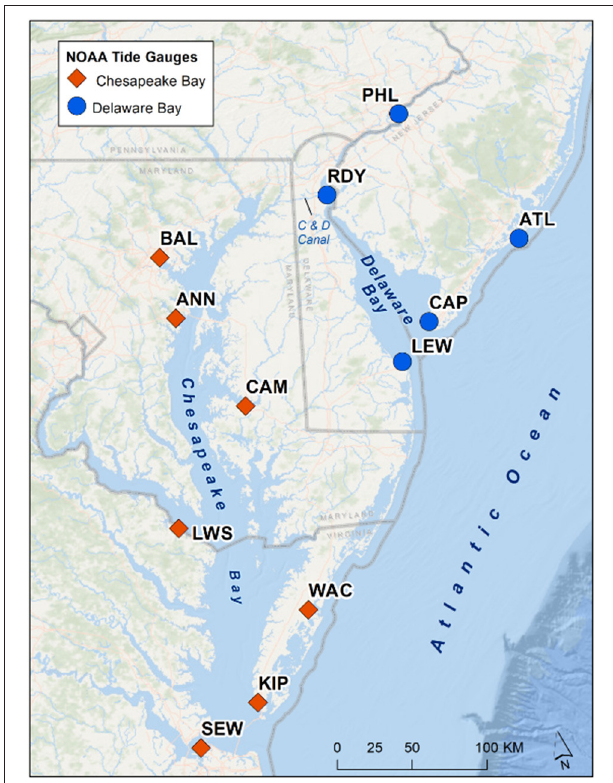
FIGURE 1 | Map of the Delaware and Chesapeake Bays with the 12 NOAA tide gauges used in the current study: PHL, Philadelphia; RDY, Reedy Point; CAP, Cape May; ATL, Atlantic City; BAL, Baltimore; ANN, Annapolis; CAM, Cambridge; LWS, Lewisetta; KIP, Kiptopeke; SEW, Sewells Point; WAC, Wachapreague.